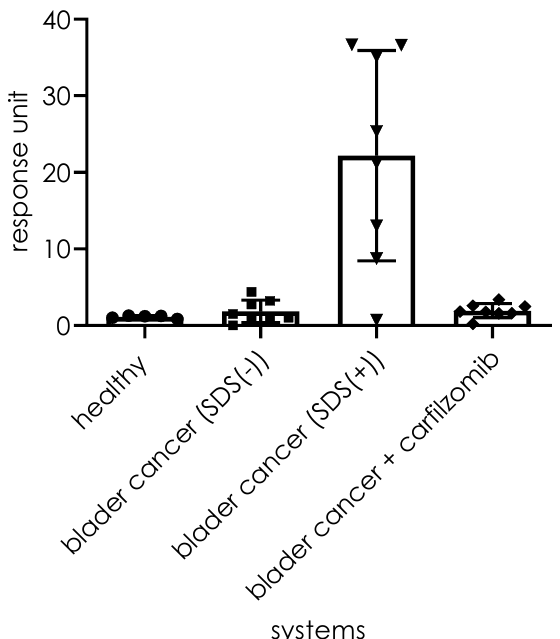
Figure 11. Aggregate analysis of the healthy and bladder cancer urine and inhibitor-treated urine.